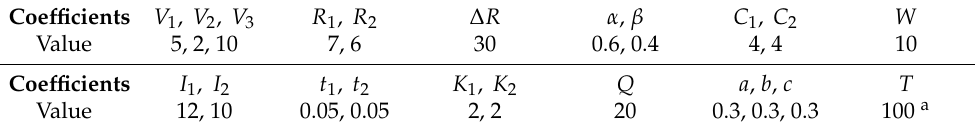
Table 5. Initial values of Coefficients.